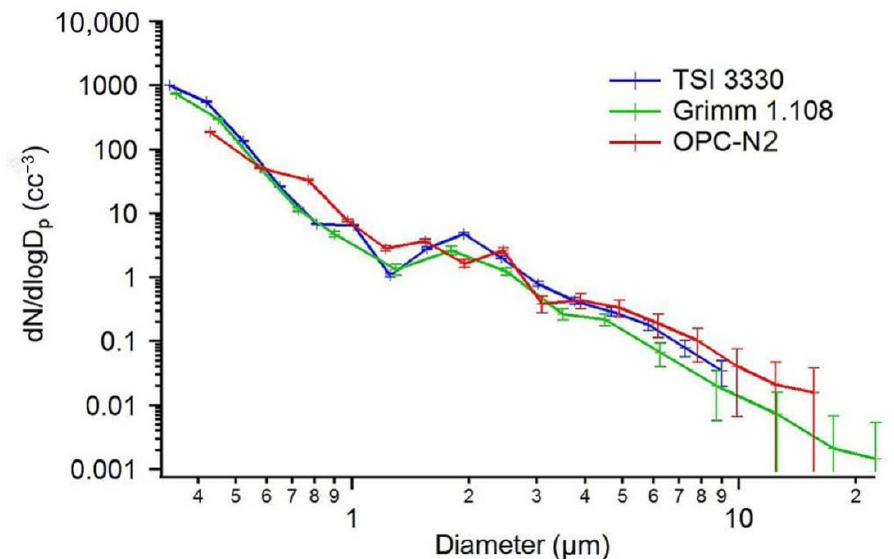
Figure 6. Particle size derivative comparison results of the three PM instruments (OPC ‐ N2, Grimm 1.108, and TSI 3330).